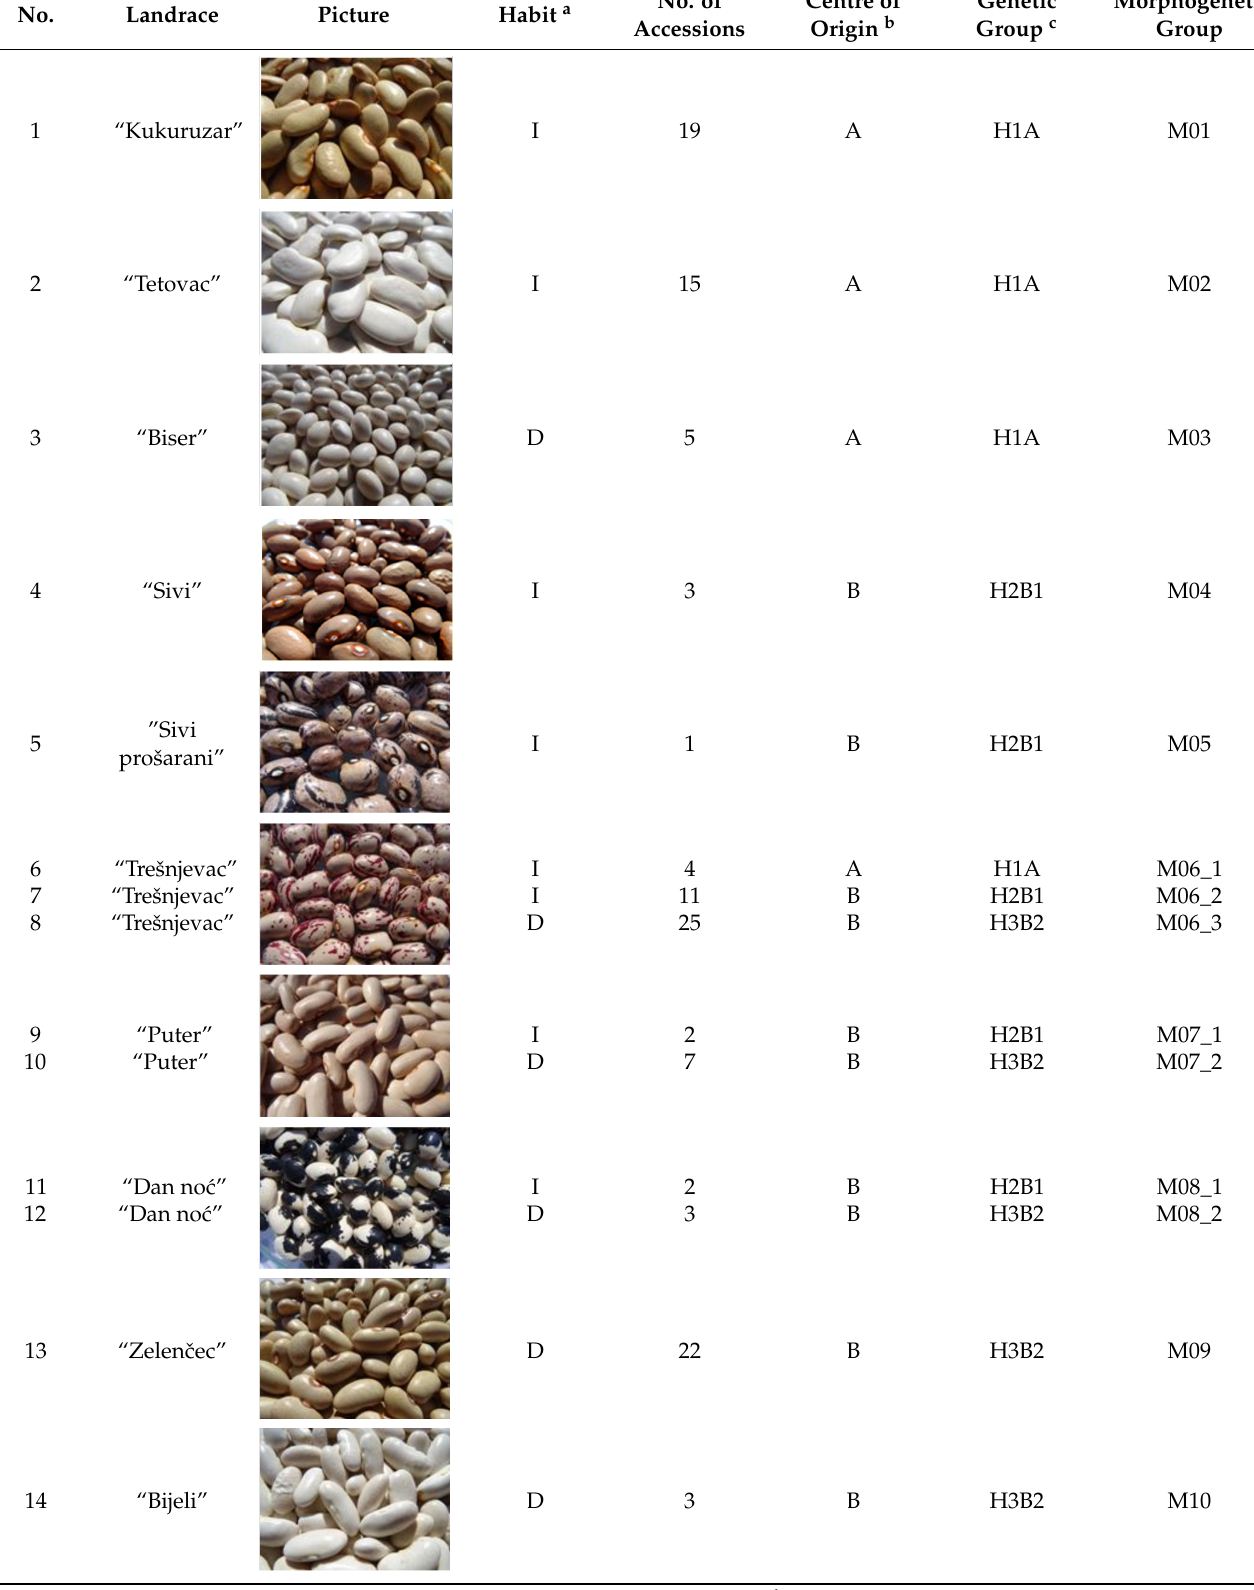
Table 2. Assignment of Croatian true-type accessions into morphogenetic groups.